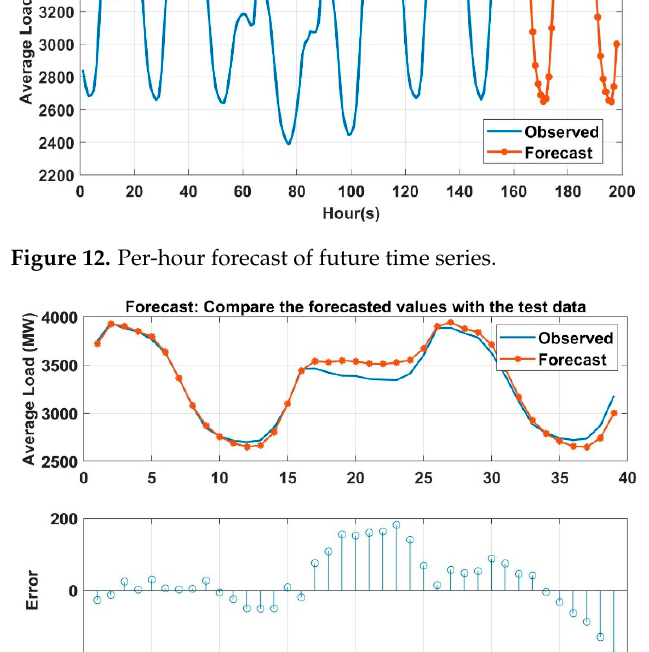
Figure 14. Comparison of per-hour forecast future time series using updated DNN model with test data (observed value).